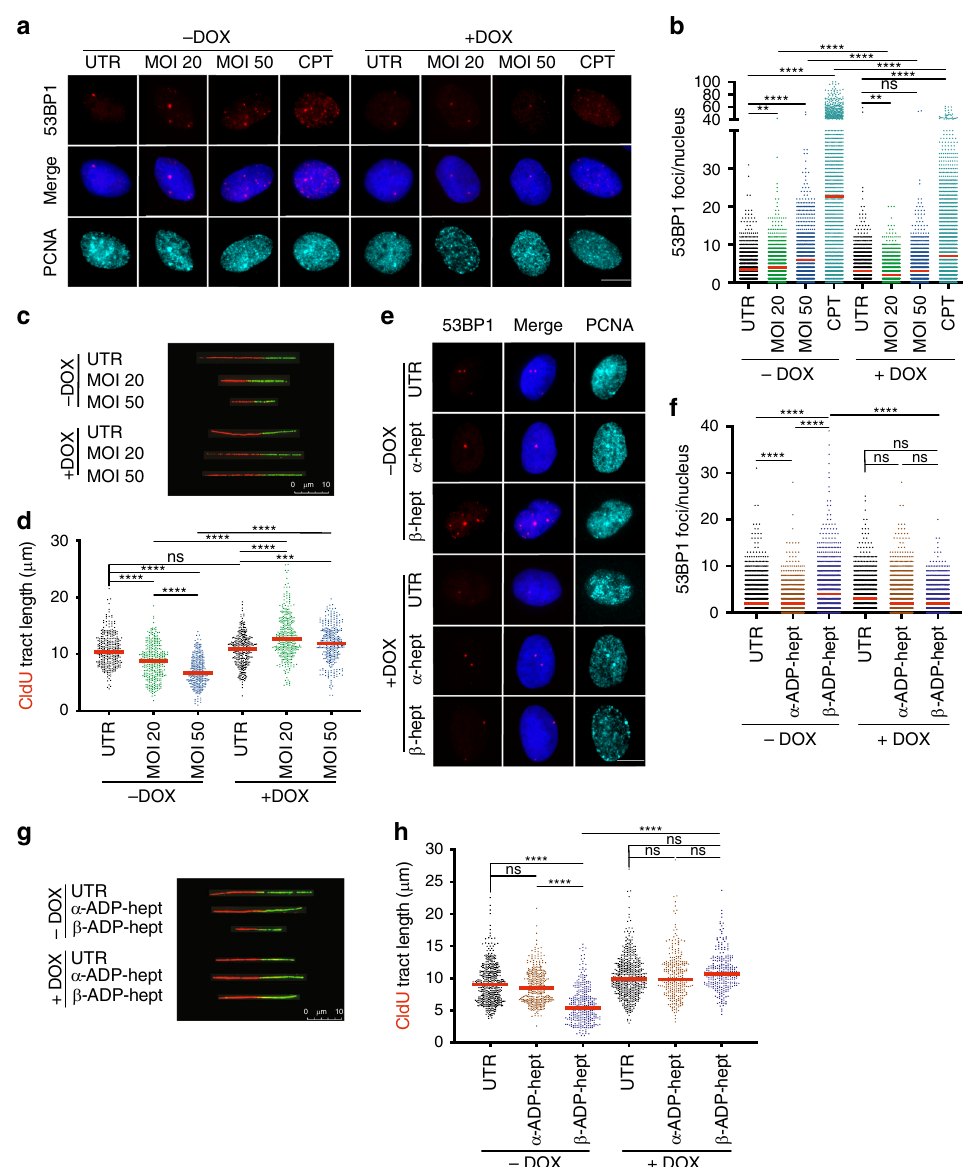
Fig. 5 H. pylori -induced DNA damage and replication stress is prevented by overexpression of RNase H1. a , b U2OS cells were either infected for 6 h with H. pylori P12 (MOI of 20 or 50), or treated with 100 nM camptothecin (CPT), and were treated or not with doxycycline ( − / + DOX) to induce the expression of RNase H1. Cells were subjected to immuno fl uorescence staining for 53BP1 and PCNA as well as DAPI. Representative images are shown in a alongside scatter dot plots of >1382 and up to 1752 cells per condition in b . Data in b are pooled from three independent experiments. c , d U2OS cells were infected as described in a , b and additionally labeled sequentially with CIdU and IdU as shown in Fig. 4a for the assessment of replication tract length. Representative DNA fi bers are shown in c and scatter dot plots of CIdU tract length (in μ m) are shown in d for the indicated conditions. At least 100 and up to 500 fi bers were analyzed per condition. Data in d are pooled from three independent experiments. e , f U2OS cells were exposed to α - or β -ADP-heptose at 0.5 μ M fi nal concentration for 6 h and treated or not with doxycycline ( − / + DOX) to induce the expression of RNase H1. Cells were subjected to immuno fl uorescence staining for 53BP1 and PCNA as well as DAPI. Representative images are shown in e alongside scatter dot plots of >1500 and up to 1752 cells per condition in f . Data in f are pooled from three independent experiments. Scale bar in a and e , 10 μ m. g , h U2OS cells were exposed to α - or β - ADP-heptose at 0.5 μ M fi nal concentration for 6 h, treated or not with doxycycline ( − / + DOX) to induce the expression of RNase H1, and additionally labeled sequentially with CIdU and IdU for the assessment of DNA fi ber tract length. Representative DNA fi bers are shown in g and scatter dot plots of CIdU tract length (in μ m) are shown in h for the indicated conditions. At least 299 and up to 514 fi bers were analyzed per condition. Data in h are pooled from three independent experiments. Red lines indicate medians throughout. In b , d , f , and h , − DOX and + DOX samples of the same condition are color- coded to facilitate comparisons. P -values were calculated by one-way ANOVA with Dunn ’ s multiple comparisons correction. ns, not signi fi cant; ** p < 0.01, *** p < 0.005, **** p <